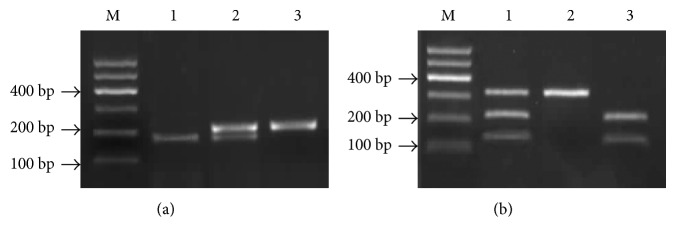
PCR-RFLP assay for PECAM-1 gene (+1688 A/G) and (+373 C/G) polymorphism. Representative electrophoresis of PCR products cleaved with restriction endonuclease Pvu II and Nhe I was shown. Lane M: DNA molecular weight marker. (a) PECAM-1 (+373 C/G) gene. Lane 1: 373CC homozygous genotype, 188 bp; Lane 2: 373CG heterozygous genotype, 255 bp and 188 bp; Lane 3: 373GG homozygous genotype, 255 bp. The 37 bp in 373 CC and 373 CG genotypes was not visible in electrophoresis gel due to its too small size. (b) PECAM-1 (+1688 A/G) gene. Lane 1: 1688AG heterozygous genotype, 338 bp, 219 bp, and 119 bp; Lane 2: 168AA homozygous genotype, 338 bp; and Lane 3: 1688GG homozygous genotype, 219 bp and 119 bp. PECAM-1: platelet endothelial cell adhesion molecule-1.